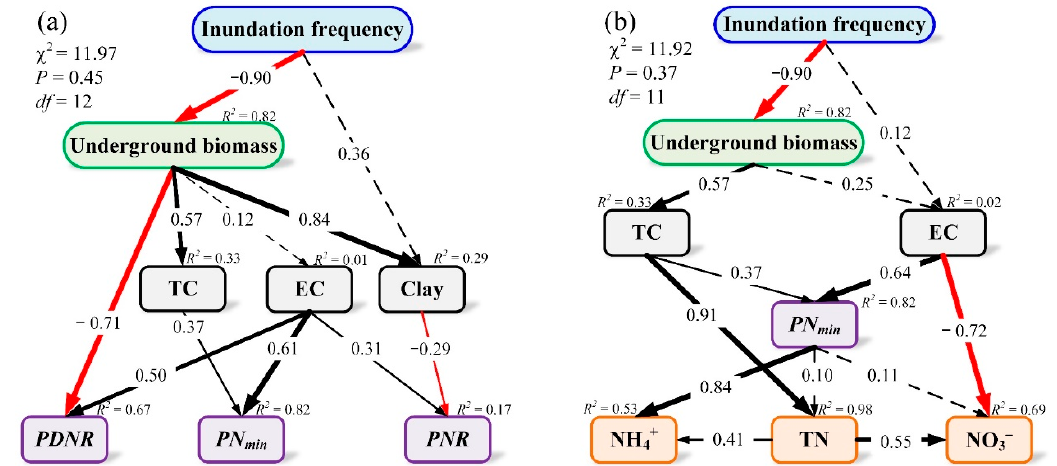
Figure 5. A structural equation model (SEM) used to assess causal mechanisms among N pools, processes, and environmental parameters. ( a ) Effects of inundation frequency, underground biomass, total carbon (TC), electrical conductivity (EC), and clay on N processes (potential rates of nitrification ( PNR ), denitrification ( PDNR ), and mineralization ( PN min )) and ( b ) effects of inundation frequency, underground biomass, TC, EC, and PN min on N pool (total N (TN), ammonium N (NH 4+ ), and nitrate N (NO 3 − )). The width of arrows indicates the strength of the standardized path coefficient. Black lines indicate positive path coefficients, and red lines indicate negative path coefficients. The solid lines indicate significant ( p < 0.05), and dashed arrows indicate no significant difference ( p > 0.05). R 2 values associated with response variables indicate the proportion of variation explained by relationships with other variables.